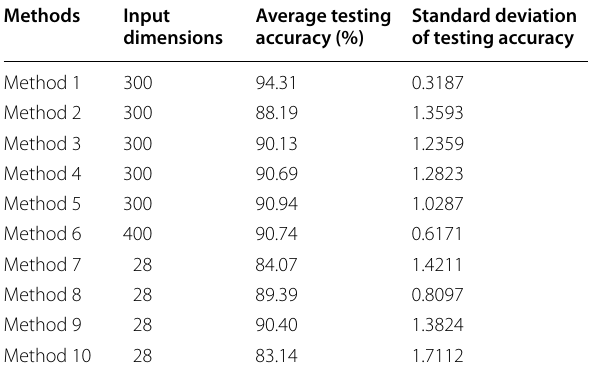
Table 2 Diagnostic results of different methods from 10 experiments